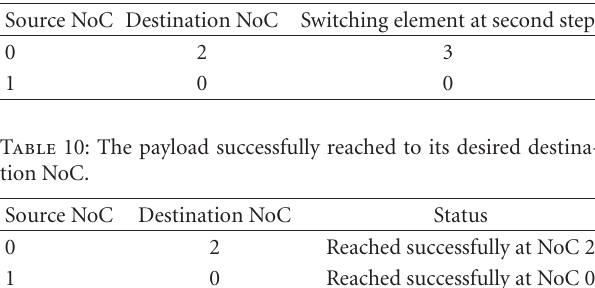
Table 9: Intermediate SE information while data moves from source NoC to destination NoC at second step of worst case.